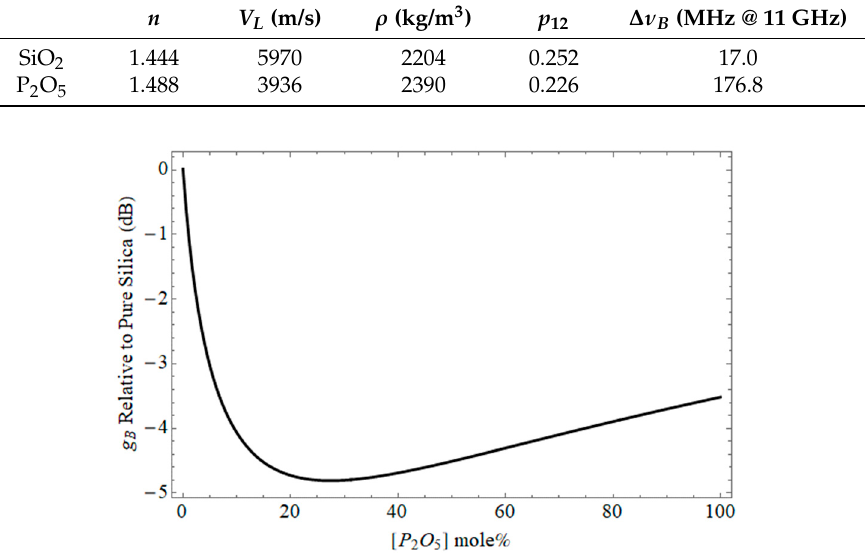
Figure 5. g B for the binary phosphosilicate glass as a function of mol % of P 2 O 5 relative to that of pure SiO 2 in units of dB. An absolute minimum is observed in the plot. Even a few mol % of P 2 O 5 can cause a significant drop in g B . Table 3. Material properties used to calculate g B for the binary phosphosilicate glass.